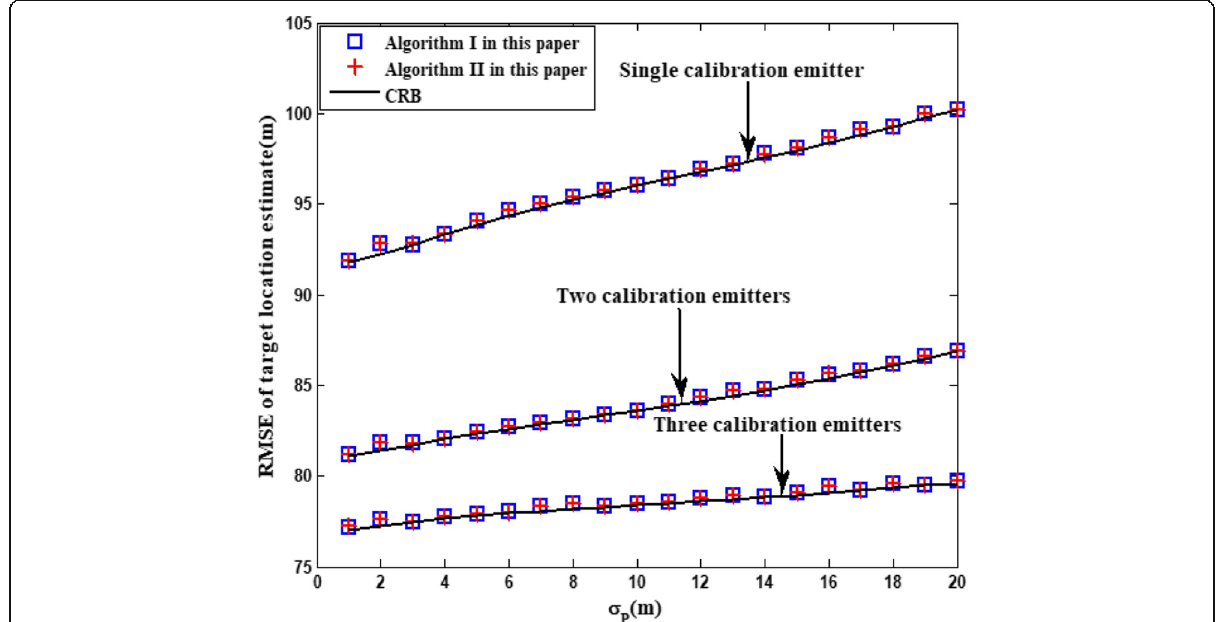
Fig. 18 RMSE of target location estimate versus σ P for a different number of calibration emitters